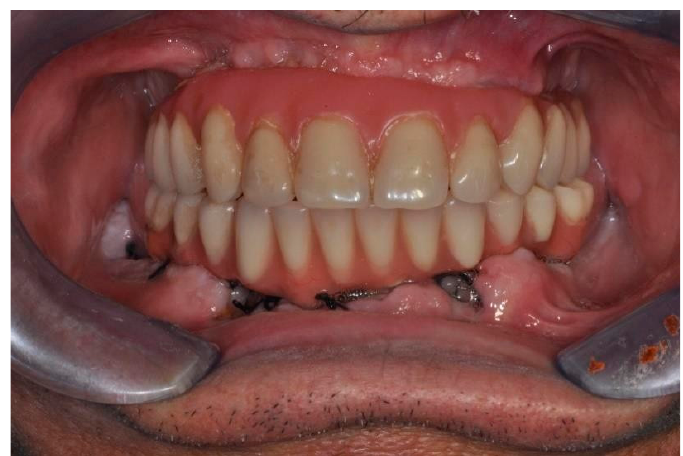
Figure 7. Frontal view of the prosthetic rehabilitation.